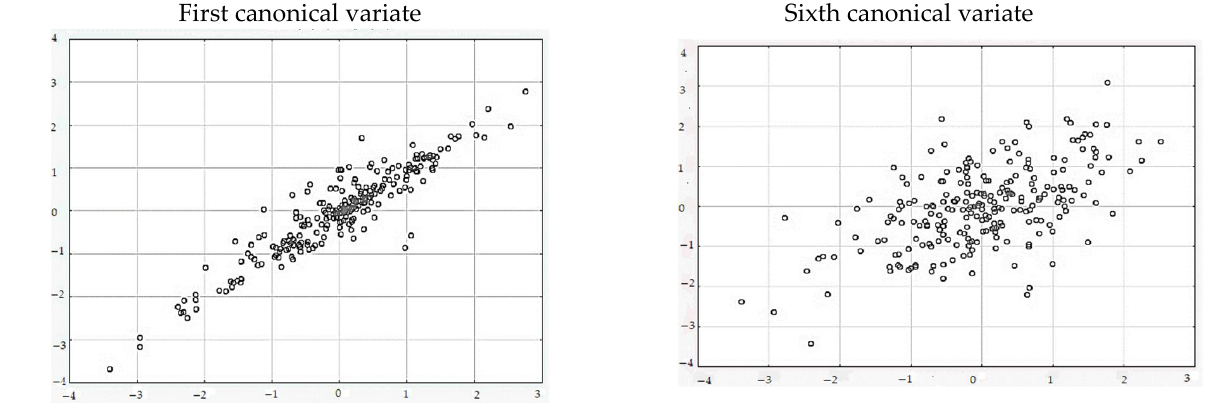
Figure 1. Dispersion graphs for the first and the last statistically significant canonical variates.